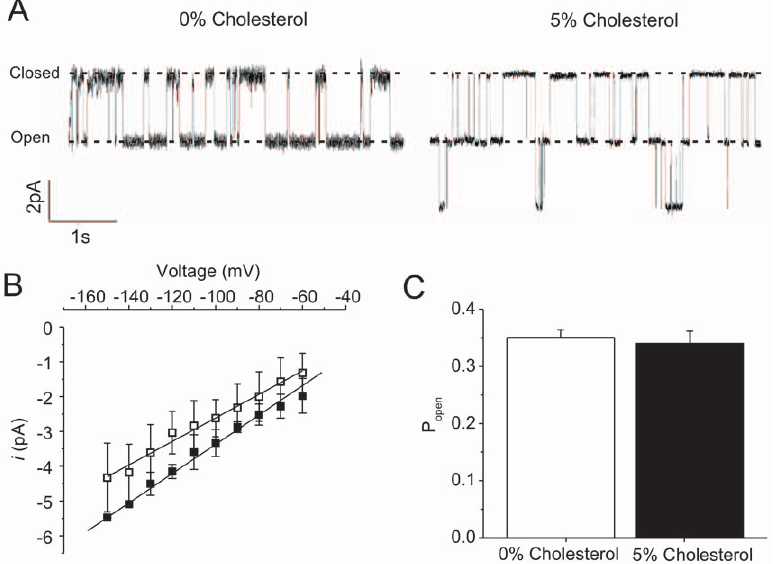
Figure 2. Cholesterol does not affect Kir2.1 open probability or unitary conductance. ( A ) Representative single-channel recordings from human Kir2.1 channels reconstituted into 3:1 POPE:POPG giant liposomes at 2 100 mV in the absence (left) or presence (right) of 5% cholesterol. Neither the unitary conductance ( i ) – voltage (V) relationships ( B ; P=0.49, n=8) nor open probability ( C ; P=0.68, n=7) were significantly different for human Kir2.1 channels reconstituted into liposomes containing 0% ( & ) or 5% ( % )